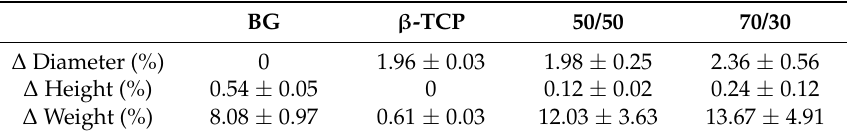
Table 7. Degradation of 3D printed Samples after immersion in SBF for 28 days ( n = 3). BG